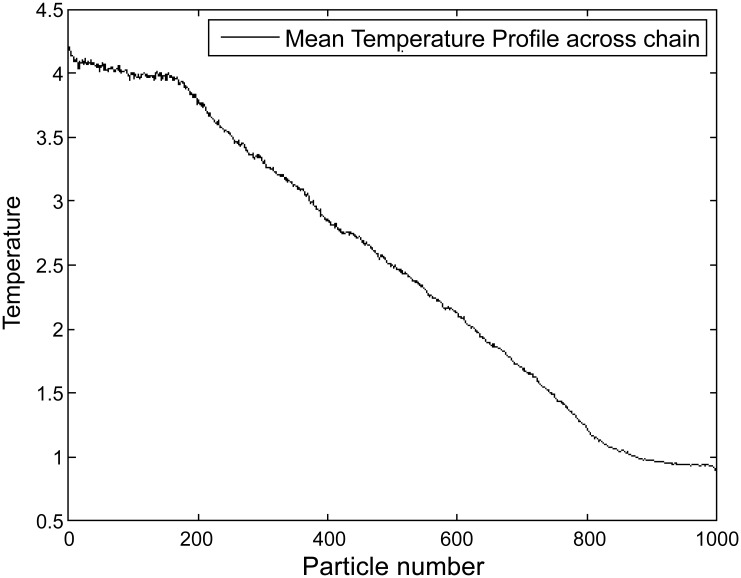
Temperature Profile across chain.From Table 1, the u.s.d. for the freely vibrating particles is of the order of 0.14 whereas the thermalized particles 1–200 are maintained at the average temperature T = 0.40014E+01± 0.8E-02, and the colder themalized particles 800–1000 have the average temperature T = 0.99987E+00± 0.2E-02.